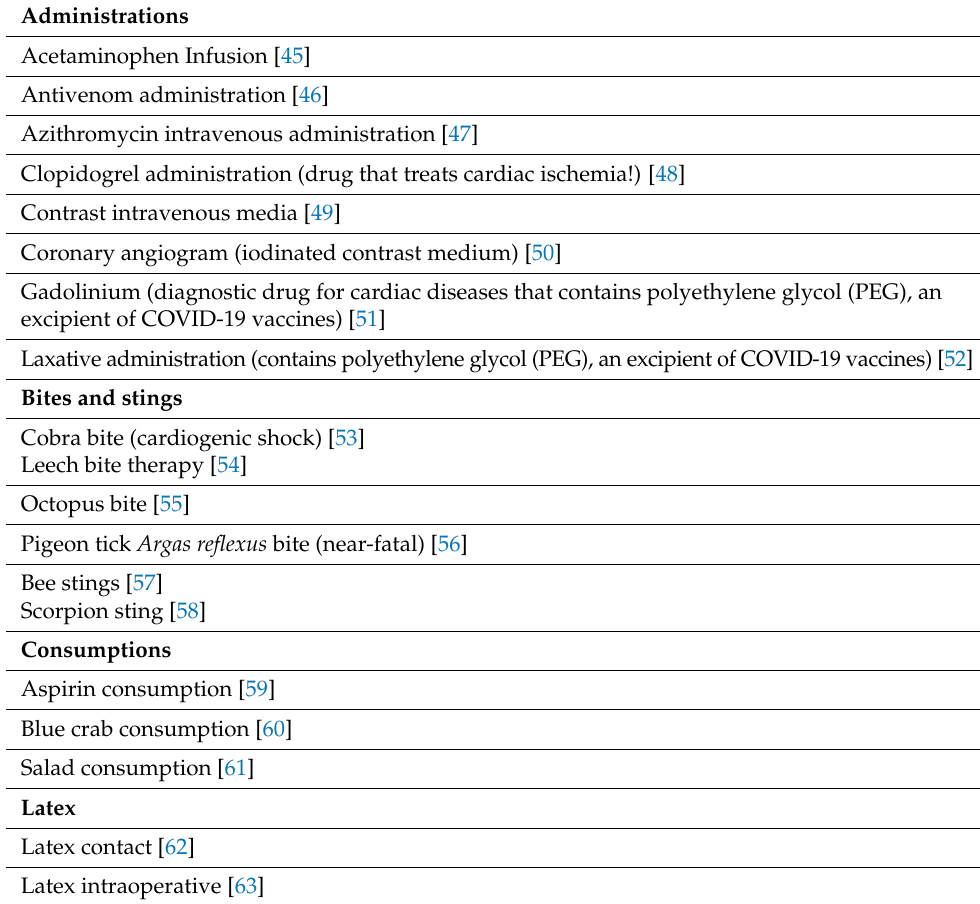
Table 2. Strange, rare causes of Kounis